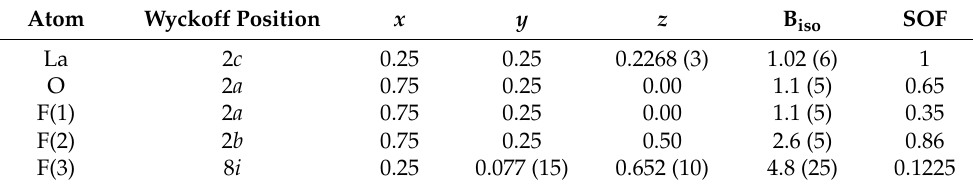
Table 2. Refined atomic coordinates and equivalent isotropic displacement parameters of LaO 0.65 F 1.7